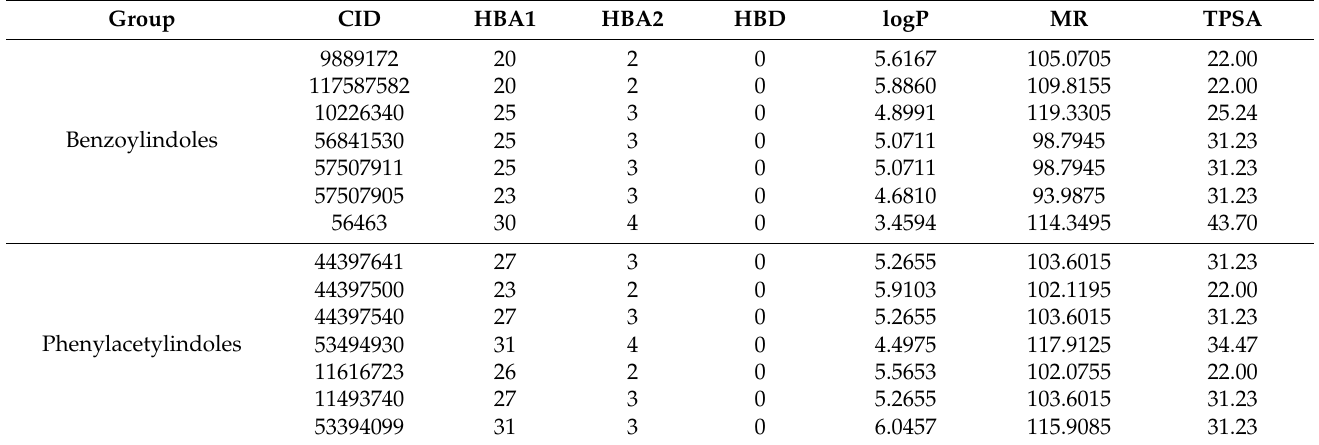
Table 3. Molecules’ descriptors.